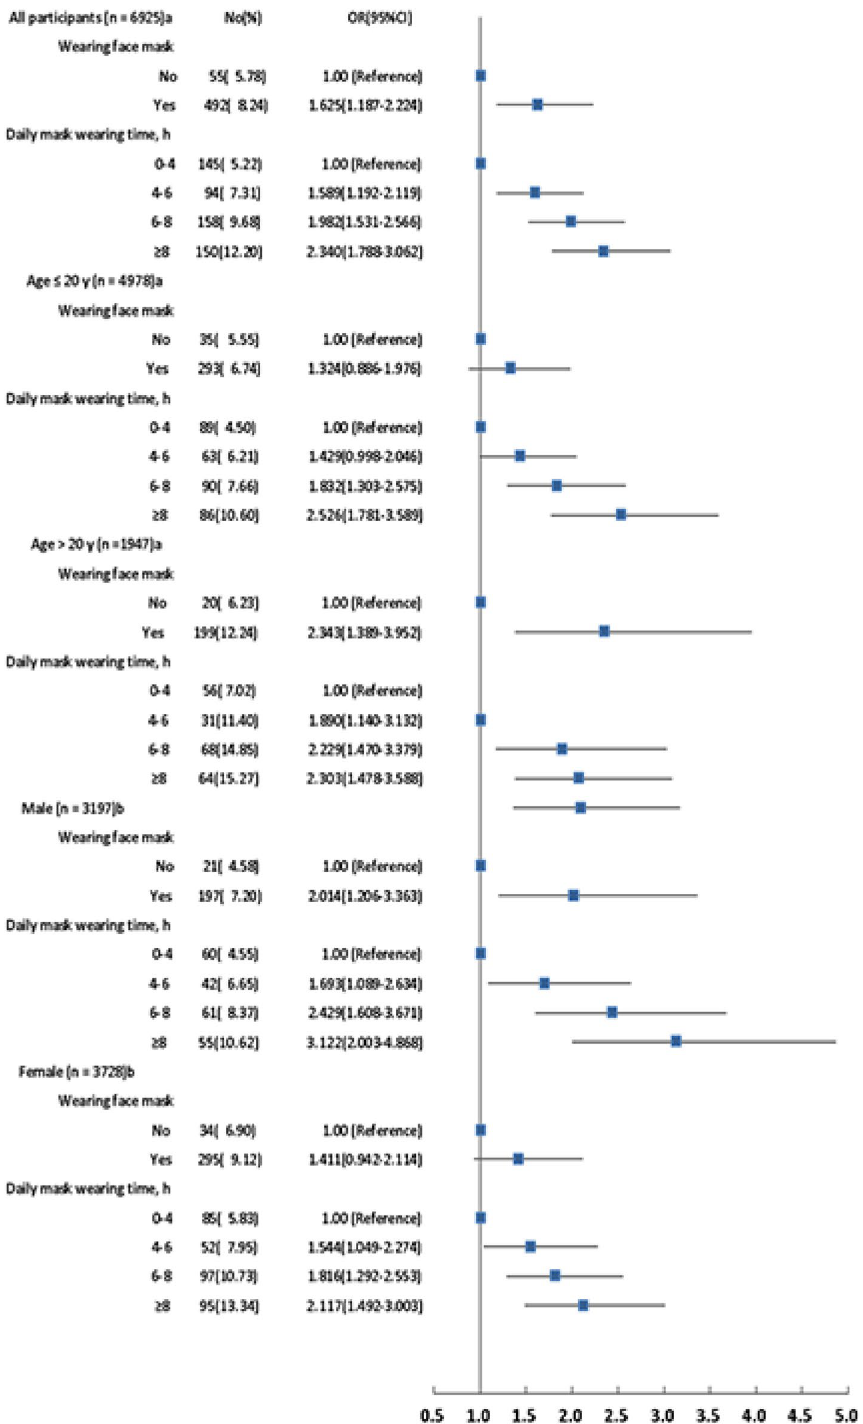
Figure. 1. Forest plot of the association of wearing face mask and daily mask wearing time with MADE according to various populations and